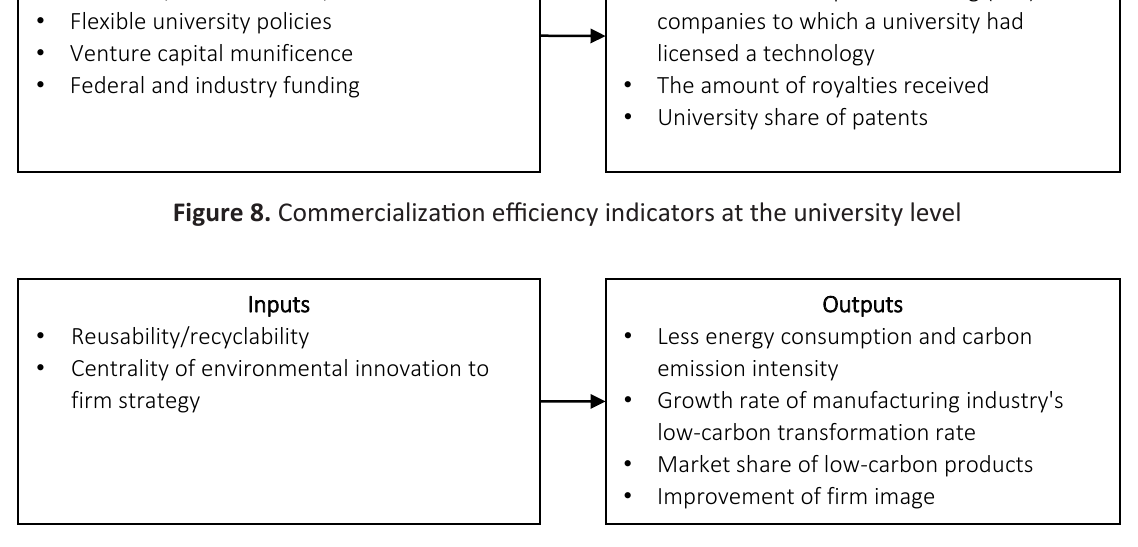
Figure 9. Commercialization efficiency indicators for sustainability-oriented